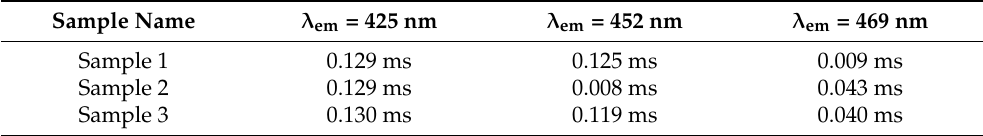
Table 3. The luminescence lifetime of the three samples for 425, 452, and 469 nm ( λ ex = 238 nm).